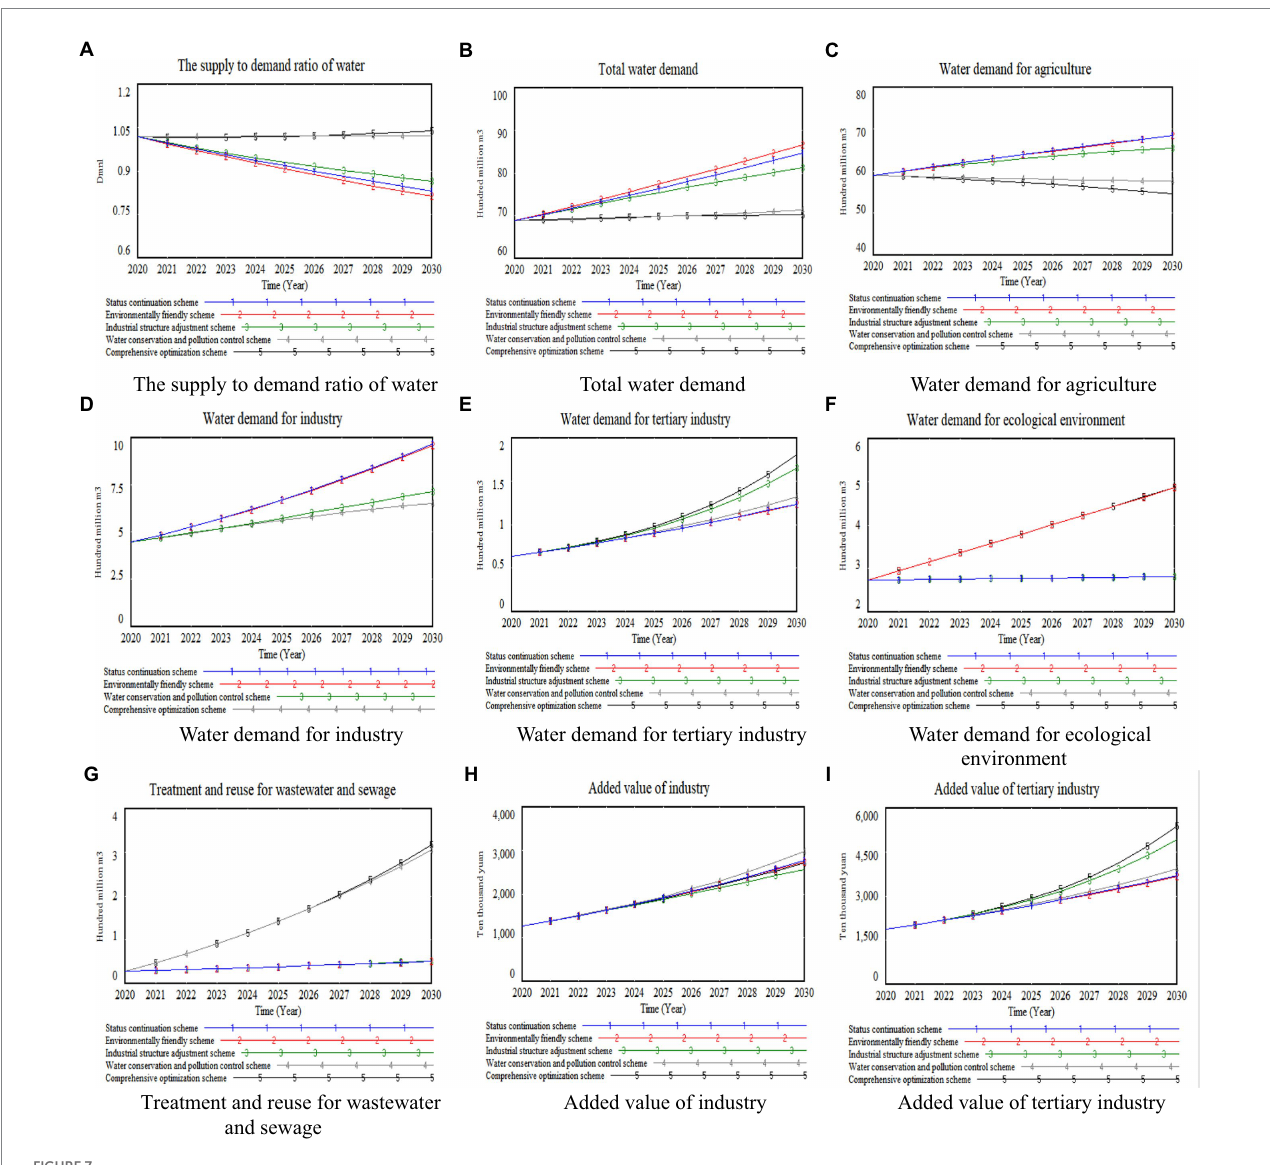
FIGURE 7 SD simulation of main variables in different regulation schemes. (A) The supply to demand ratio of water. (B) Total water demand. (C) Water demand for agriculture. (D) Water demand for industry. (E) Water demand for tertiary industry. (F) Water demand for ecological environment. (G) Treatment and reuse for wastewater. (H) Added value of industry. (I) Added value of tertiary